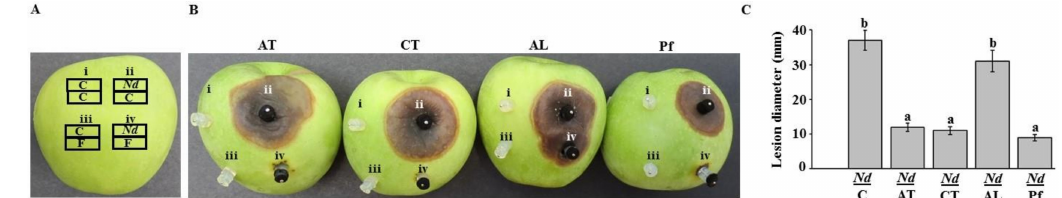
Figure 6. In vivo inhibitory e ff ect of the chemical fungicides against Neoscytalidium dimidiatum using the “apple fruit bioassay”. An illustration showing ( A ) inoculated-apple fruit with the chemical fungicides and / or N. dimidiatum agar plugs in combinations; ( B ) apple fruit bioassays using chemical fungicides; and ( C ) lesion diameter of N. dimidiatum using 250 ppm of the fungicides after 10 dpi. In ( A–B ), (i) two sterile non-inoculated PDA agar plugs; (ii) N. dimidiatum inoculum alone with a sterile agar plug below it; (iii) the fungicide (F) alone with a sterile agar plug above it; and (iv) pairing N. dimidiatum and the fungicide together, with the fungicide on the apple surface and N. dimidiatum -inoculated plug on top of the fungicide. In ( C ), values with di ff erent letters are significantly di ff erent from each other at p < 0.05. C, control (no N. dimidiatum ); Nd , N. dimidiatum; F, fungicide; AT, Amistar Top ® , CT, Cidely ® Top; AL, Airone Liquido ® ; Pf, Protifert ® ; dpi, days post